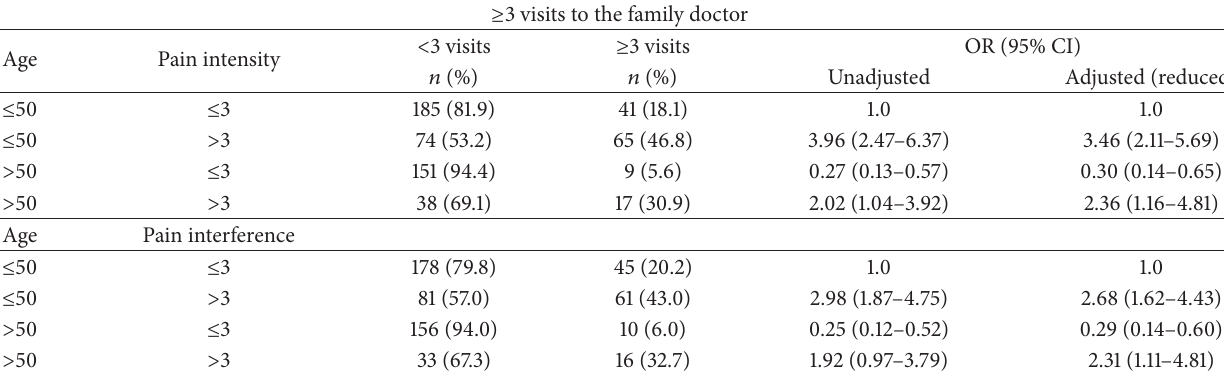
Table 5: Exploration of the interaction between age and pain intensity and frequent visits to the family doctor. ≥ 3 visits to the family